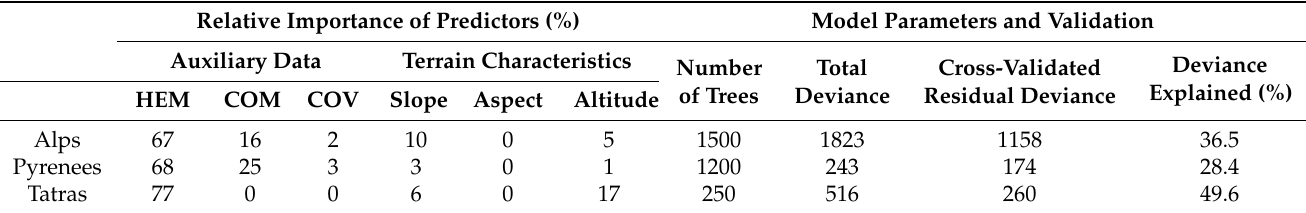
Table 5. Performance of BRT models of the absolute vertical error (|dh|) of TDX90 and the relative importance of predictors.